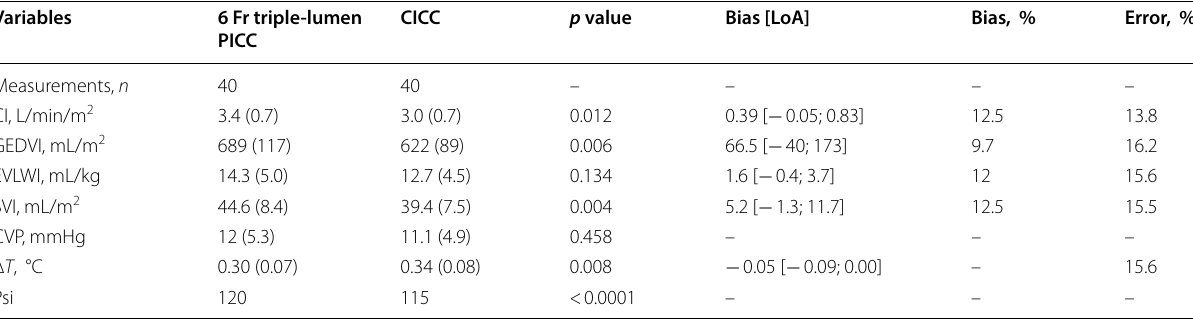
Data are reported as mean (standard deviation)